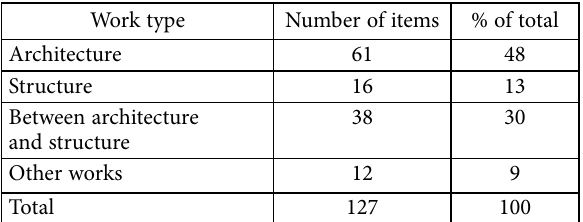
Table 4. Classification of the work type